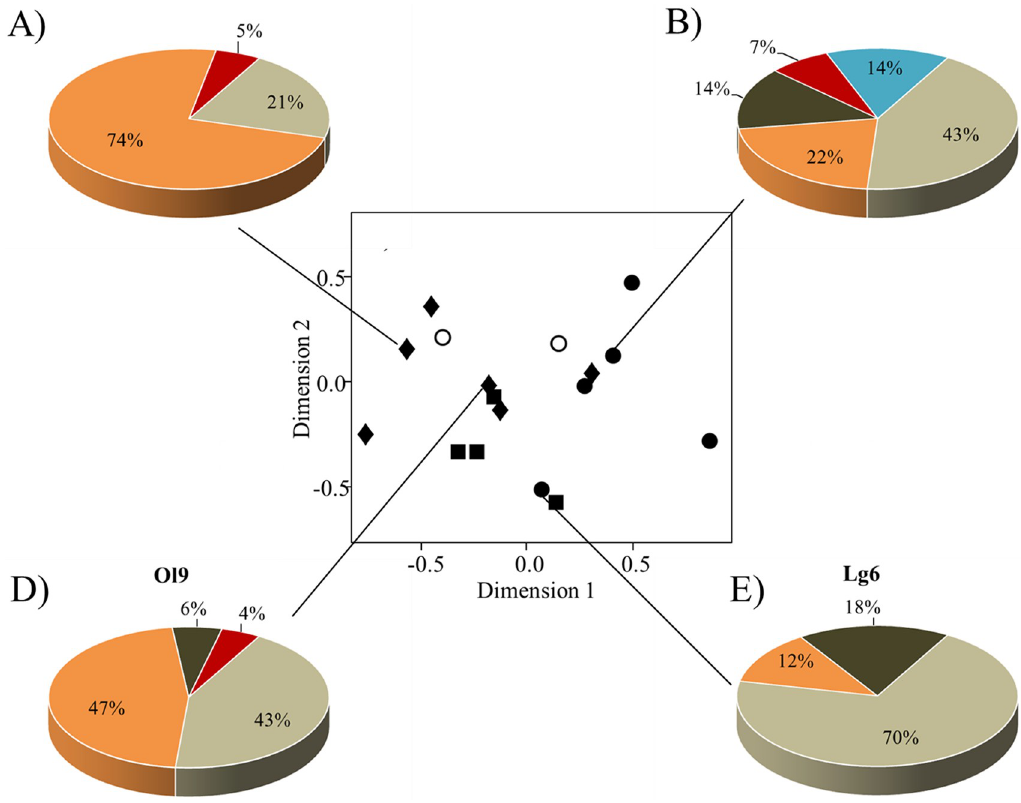
Fig 3. Variation in resin spectra collected by 16 colonies from four different apiaries/sites. Bees collected varying amounts of up to five different types of resin (“ocher”, “orange”, “brown”, “red”, “clear”). Ordination figure (C) shows similarities among colonies from different sites based on Bray-Curtis dissimilarities between samples (stress value = 0.06). Sites are represented by different symbols: closed circle, “Lg”; closed diamond, “Ol”; closed square, “Gr”; open circle, “Ml” with each symbol representing a single colony (for meaning of abbreviations see Table 1). Circular charts (A–B) and C—D) display proportions of resin types collected by four examplary colonies from two different sites (site “Ol”: A) colony ID 8: N resin samples = 19, and B) ID 9: N = 88; site “Lg”: D) ID 4: N = 14 and E) ID 6: N =